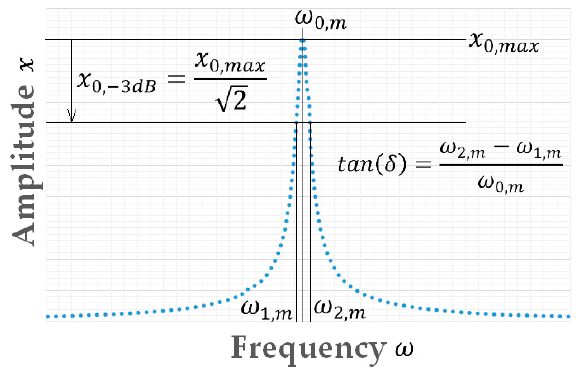
Figure 5. Estimation of the dissipation factor tan ( δ ) at m -th natural frequency of a FRF.